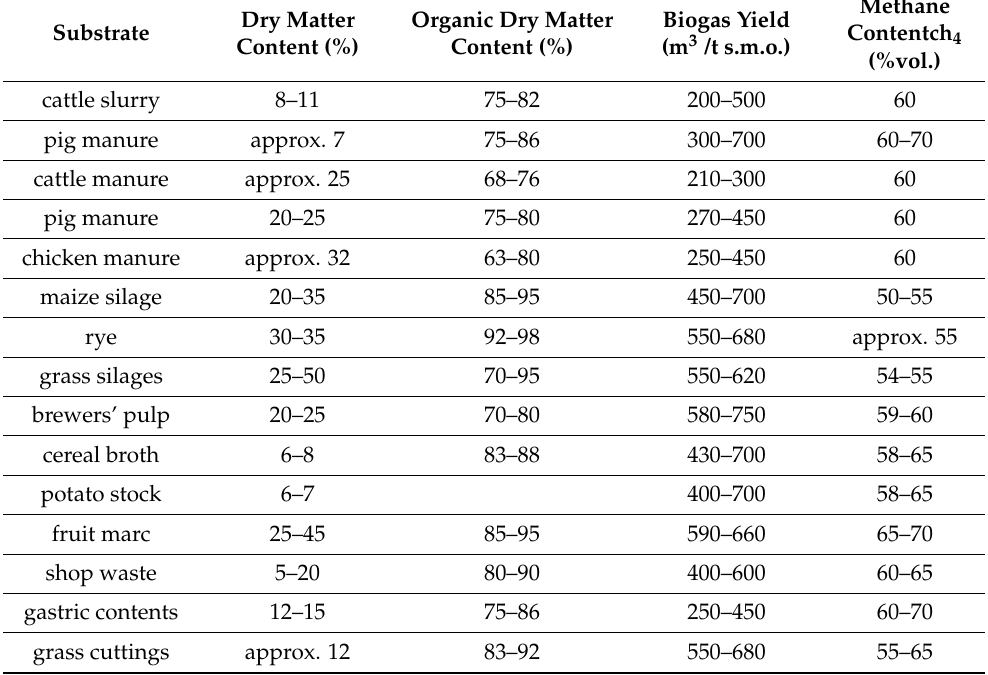
Table 1. Characteristics of selected plants and selected by-products in terms of biogas yield